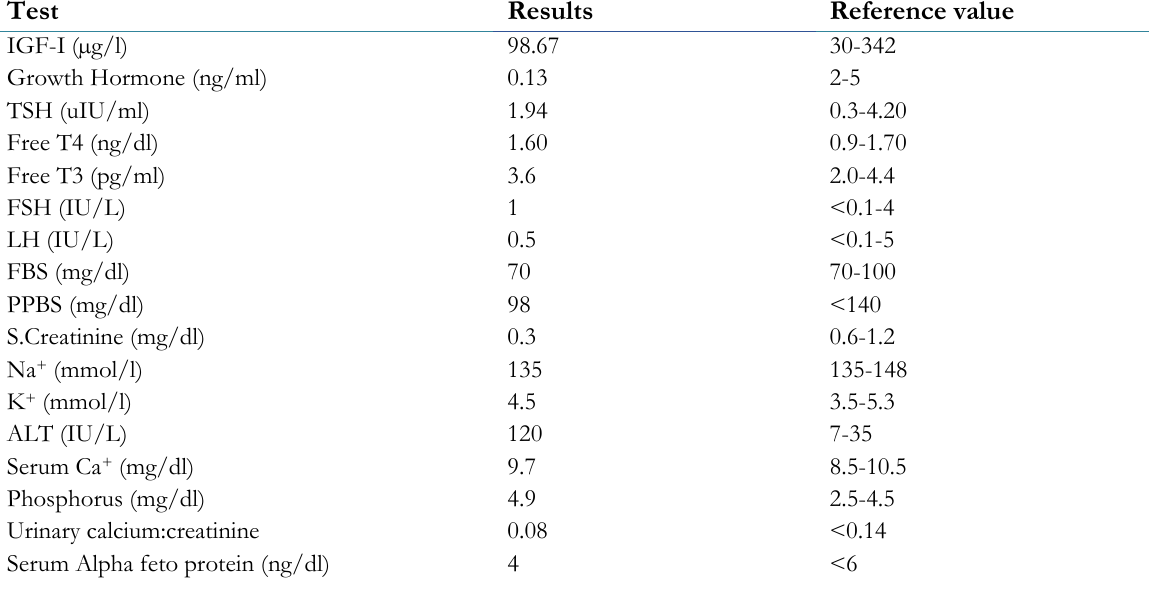
Table 1: Hormonal and biochemical investigations of a child with BWS